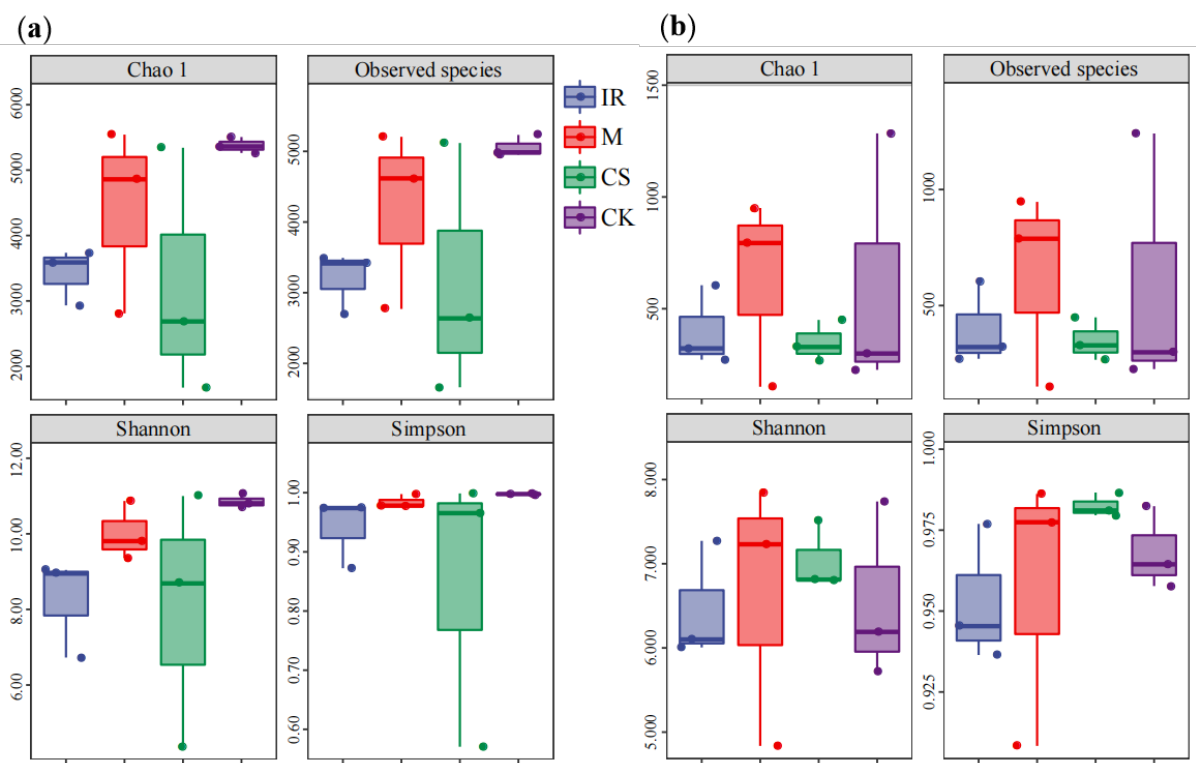
Figure 3. Soil bacterial and fungal richness and diversity. ( a ) Bacteria; ( b ) fungi. IR, Italian Riesling; M, Merlot; CS, Cabernet Sauvignon; CK, control check (desert land).